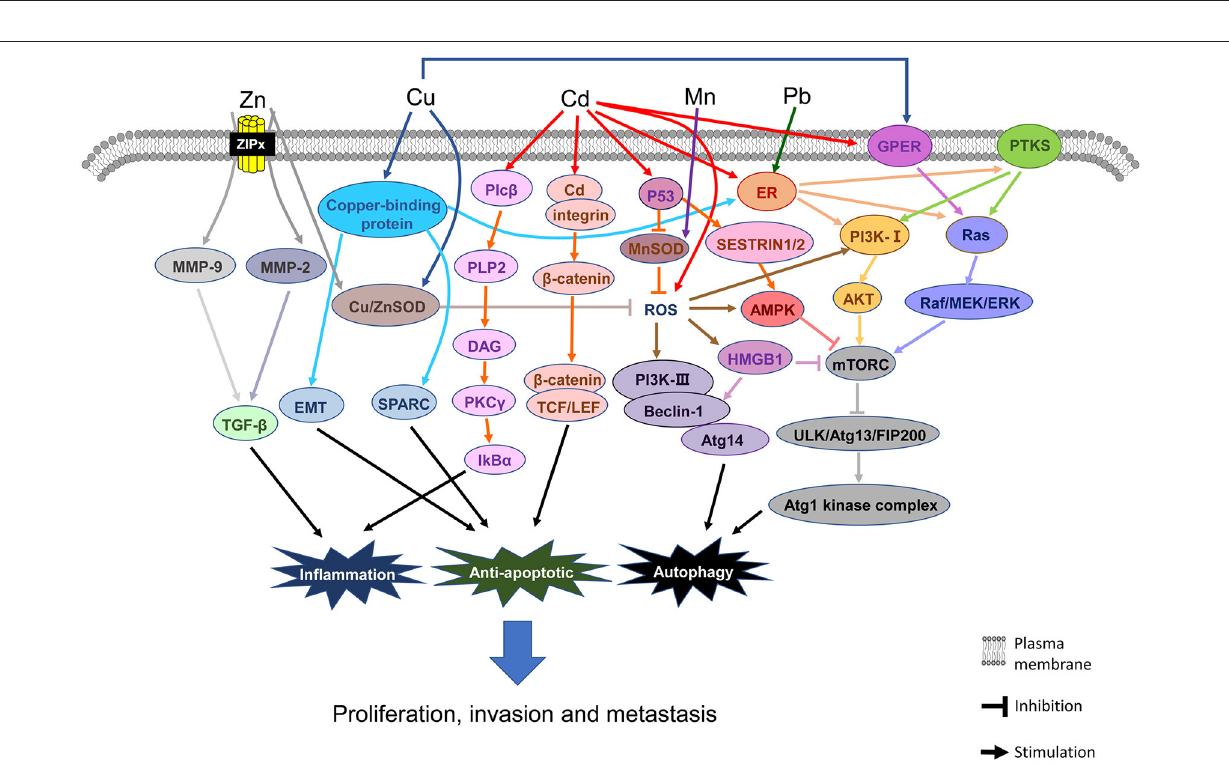
FIGURE 6 | Signaling pathways involved in the associations between heavy metals and breast